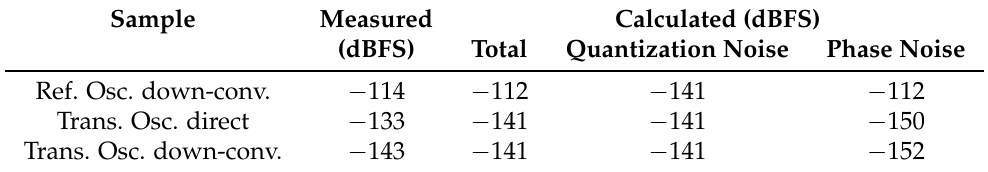
Table 1. In-band total noise